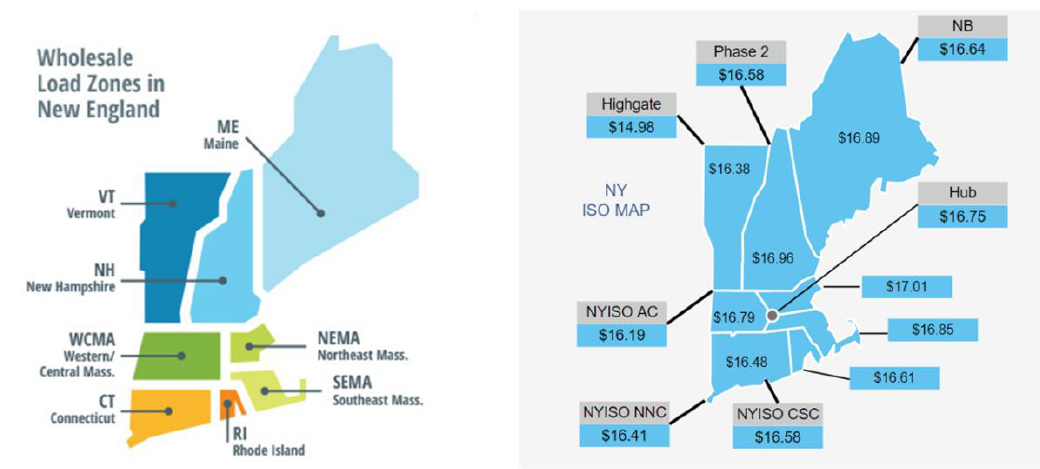
Figure 4. Eight load zonal map ( left ); and hourly day-ahead LMP Prices for zones, hub, and import interface locations ( right ). Reprinted with permission from ISO New England.